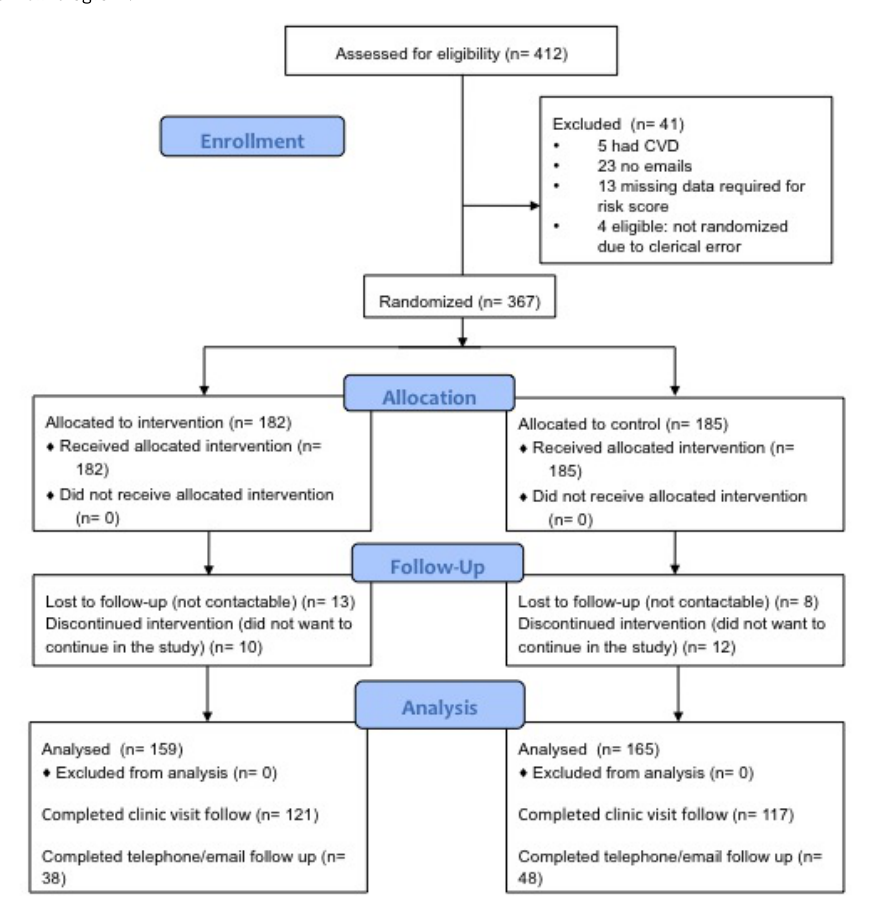
Figure 8. Participants' flow